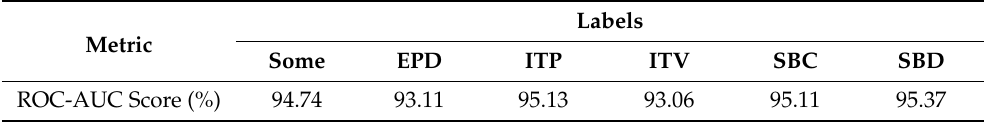
Figure 8. ROC-AUC plot for ICH and its sub-types. Table 6. ROC-AUC score for different labels. Metric